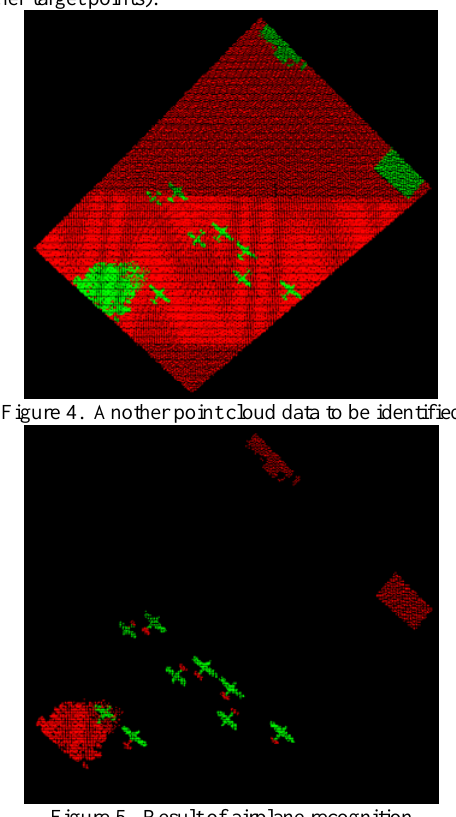
Figure 5. Result of airplane recognition